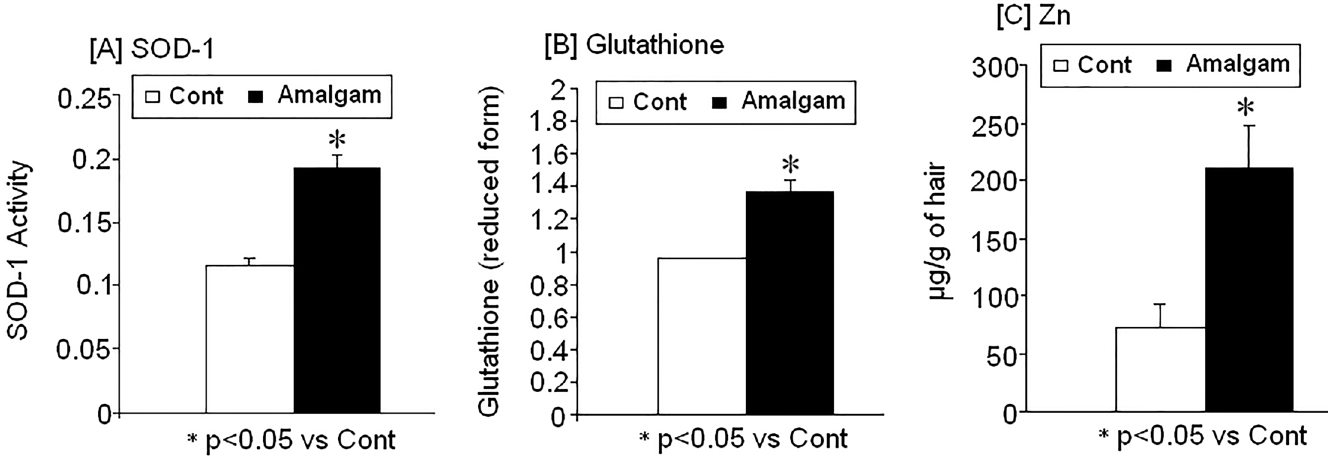
There were no differences for Sn, Ni, Bi, Ti. Pb, Cd or either (data not shown: Sb, Be, Bi, Tl, Th, U; μ g/g).p > 0.05: n.s ( Sb, Be, Bi, TI, Th, U ); (p > 0.05;